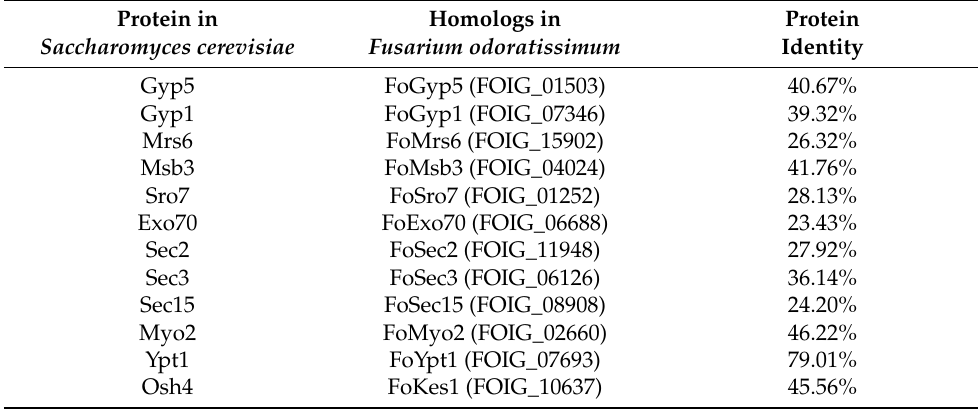
Table 1. Homologs of 12 interactors of S. cerevisiae Sec4 in F. odoratissimum